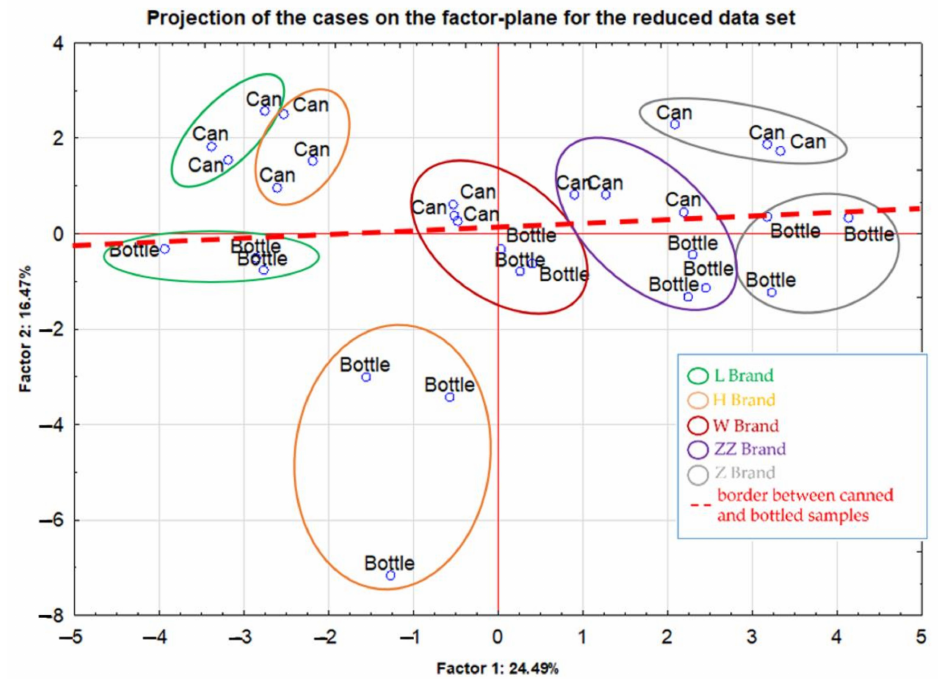
Figure 3. Projection of the cases on the factor-plane for the reduced data